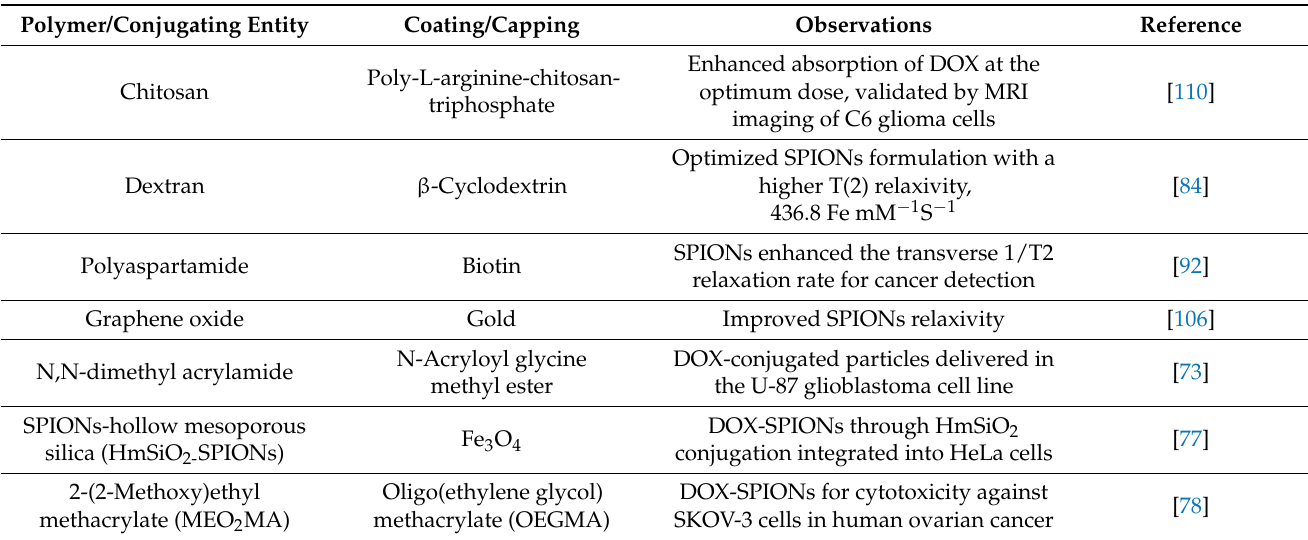
Table 2. SPIONs-conjugated systems for DOX